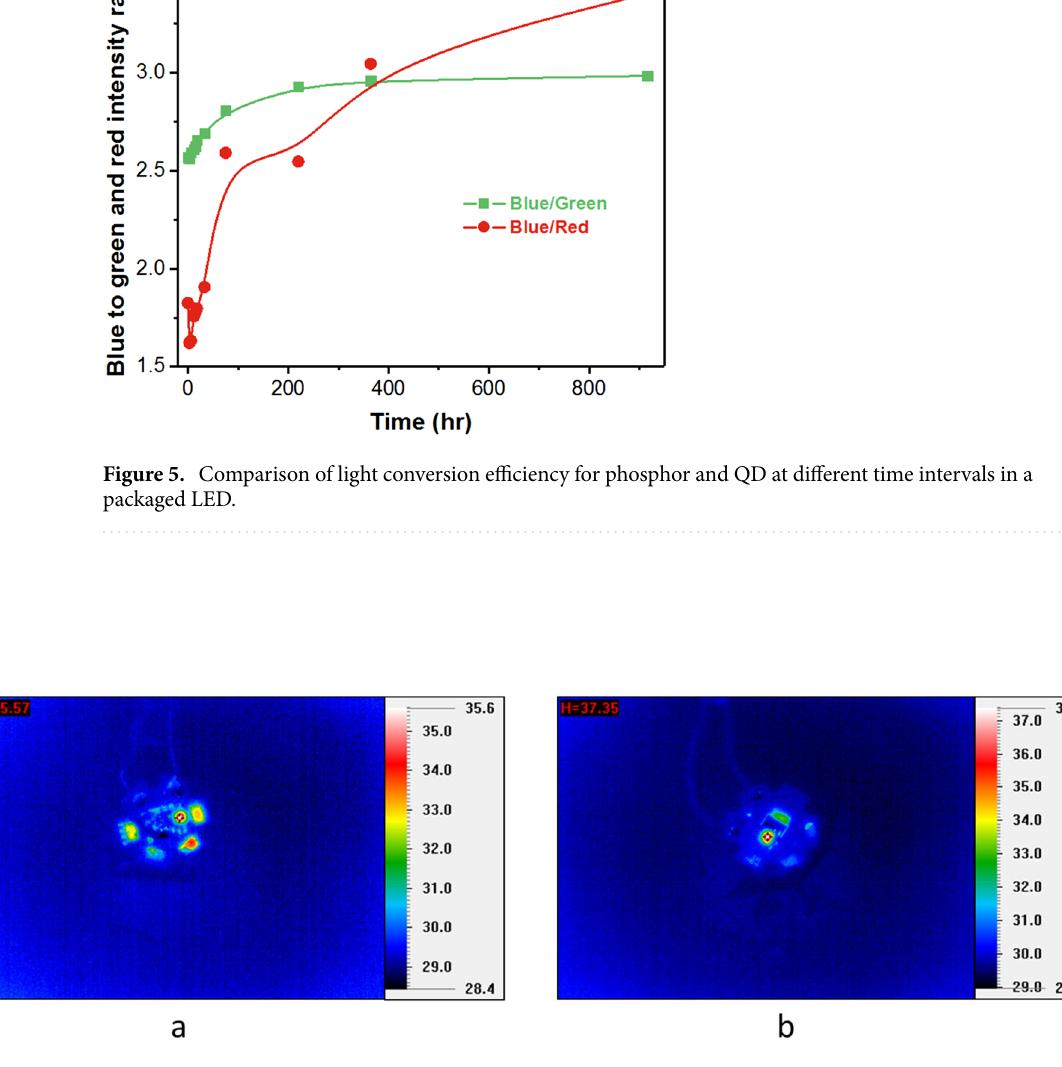
Figure 6. Comparison comparison between heat generation in LEDs ( a ) before and ( b ) after the test. Measurement is done using IR Camera (CHCT P384A-20 Thermal Scanning